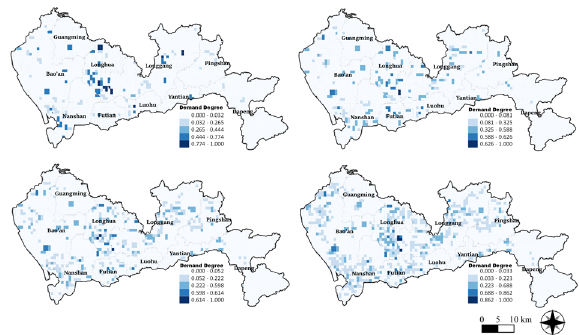
Figure 6. Demand degree of residents' living materials under different extents of simulation